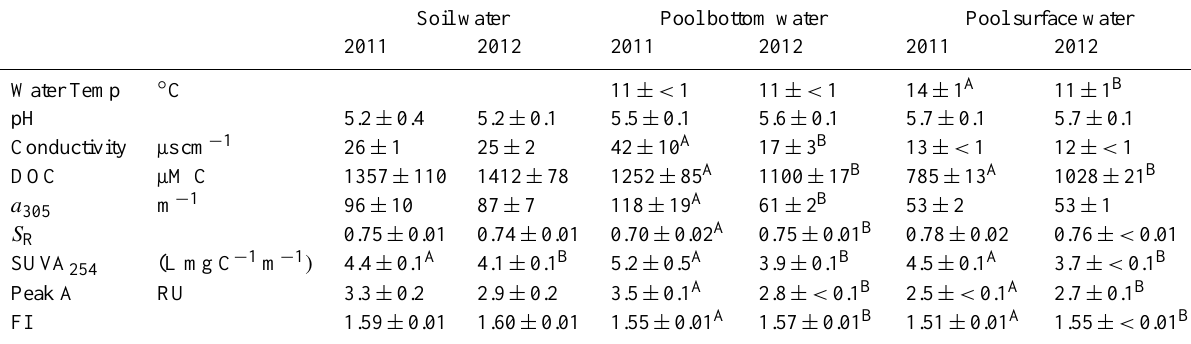
Table 2. Annual average hydrologic and chemical characteristics of soil and stream water samples from Imnavait